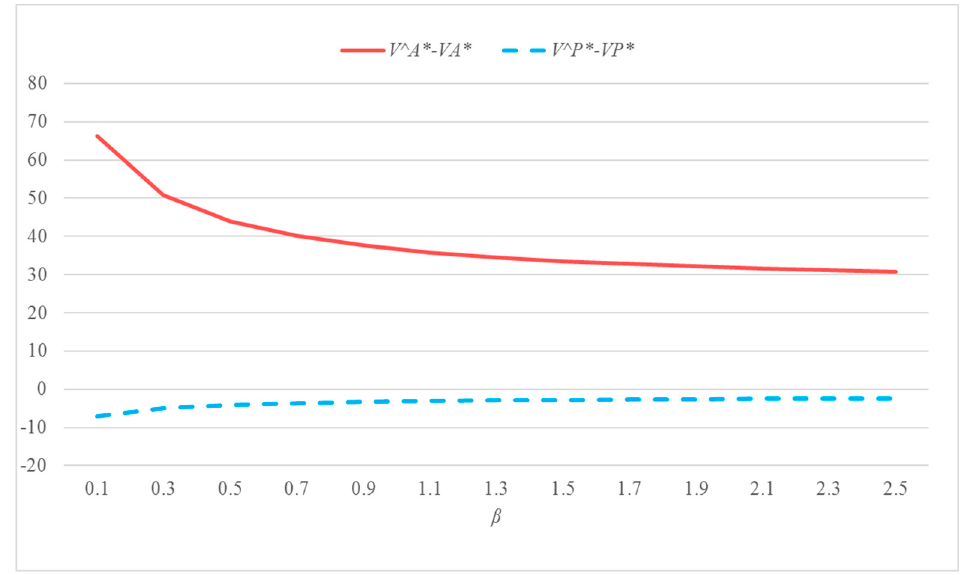
≥ V ∗ ≤ V ∗ ** ˆ Figure 4. Part (iii): ˆ V ∗ and ˆ V ∗ . Notes: Figure 4 is generated based on P = 10, µ 1 = 0.4, VV ≥ and ** ˆ VV ≤ . Notes: Figure 4 is generated based on P = 10, μ Figure 4. Part (iii): P P A A AA PP µ = 0.3, θ = 0.4, θ = 0.2, δ = 0.4, α = 0.5, η = 0.3, η = 0.5, λ = 0.4, ρ = 0.3, R 2 1 2 1 2 = 0.3, θ 1 = 0.4, θ 2 = 0.2, δ = 0.4, α = 0.5, η 1 = 0.3, η 2 = 0.5, λ = 0.4, ρ = 0.3, R 0 = 20, and G 0 = 200.